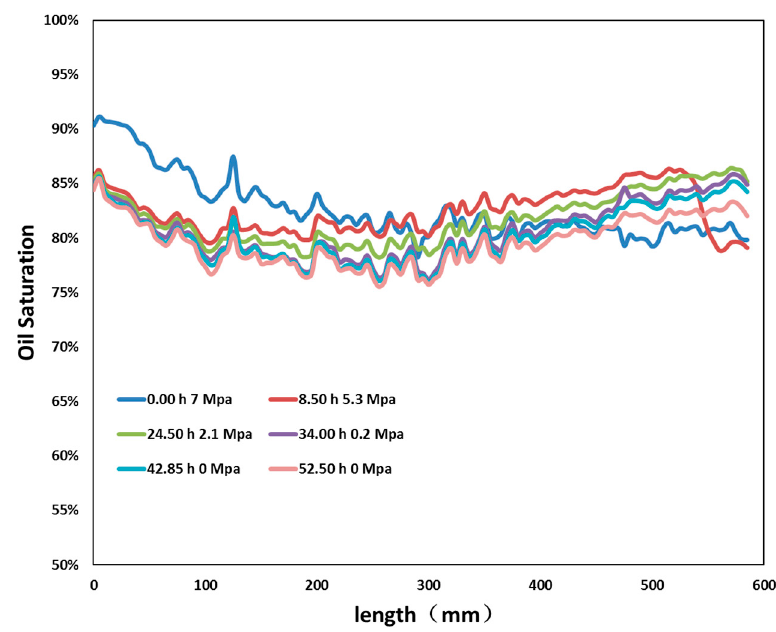
Figure 11. Oil saturation distribution curves in Experiment 4—gas cycling part.